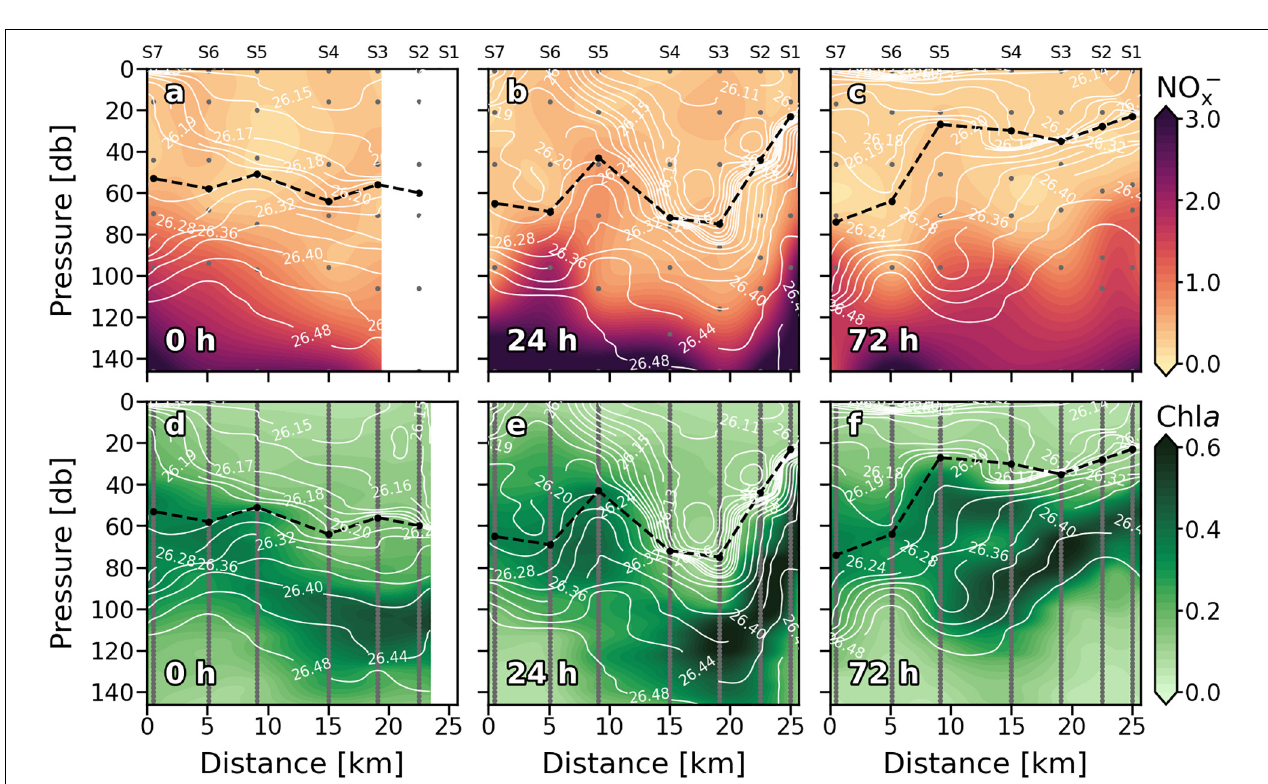
FIGURE 3 | Vertical sections of vertical velocities (w GL ; m · day − 1 ) for every sampling days (a–c) . Stations are indicated in the upper part of the plot. Nutrient (mmol · m − 3 ) field is superimposed as solid white lines. Sampling depths are represented by gray dots. Positive (negative) values indicate upward (downward) velocities. Dashed black line indicates the mixed layer depth.